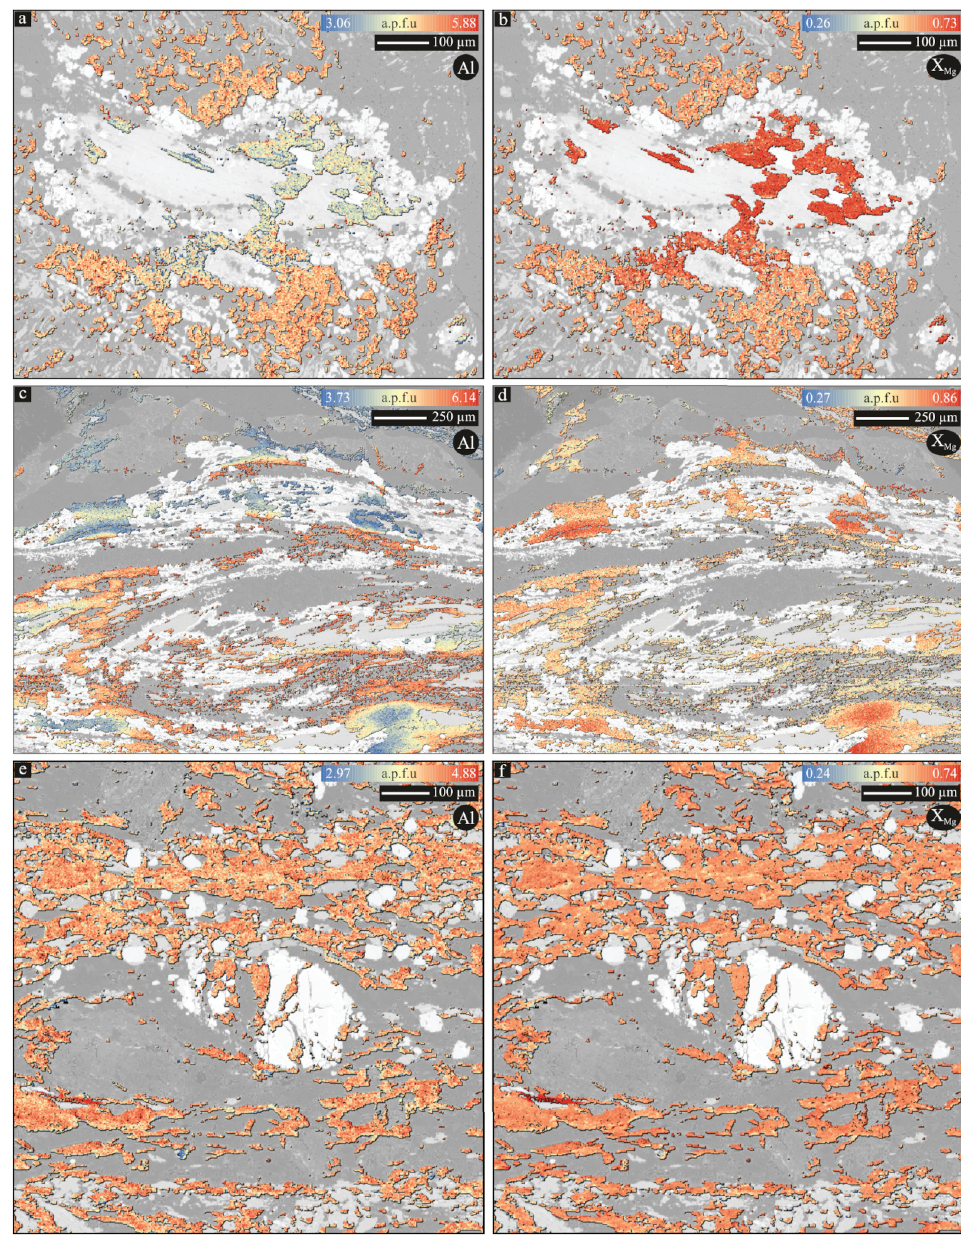
Figure 10. Calibrated maps of white mica: ( a , b ) calibrated maps of Al and X Mg of LdV white mica; ( c , d ) calibrated maps of Al and X Mg of MM white mica; ( e , f ) calibrated maps of Al and X Mg of RCT white